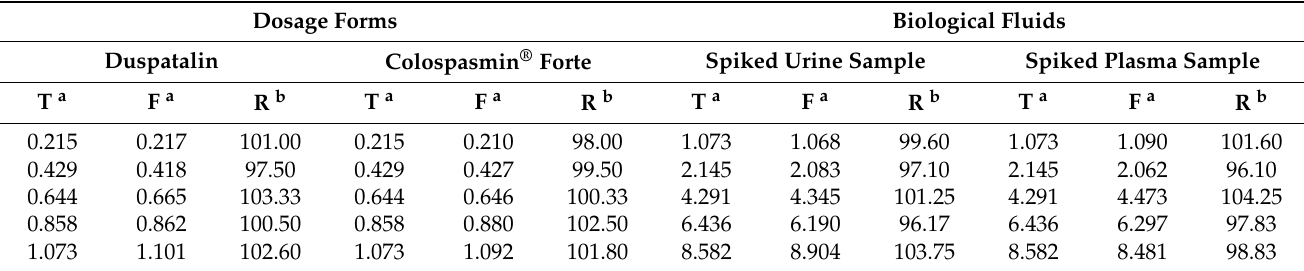
Table 4. Recovery percentage for the determination of MEB in dosage forms and biological fluids samples using Cu 2